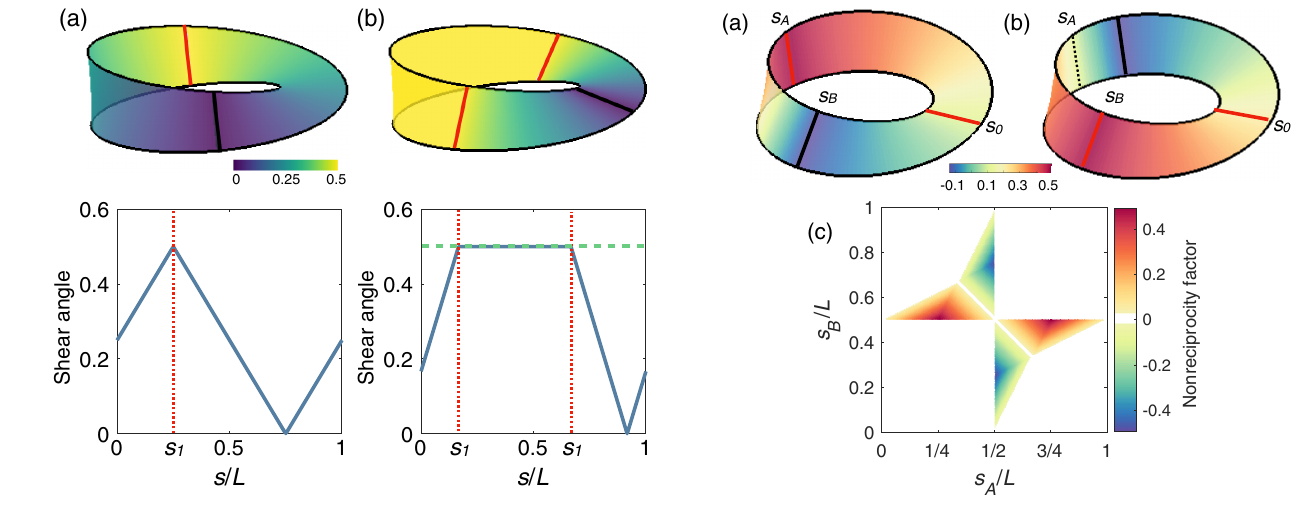
FIG. 3. Nonlinear response to shear stress. Top panels: The color indicates the magnitude of the shear angle along the Möbius strips. The red lines show the positions of the applied stresses and the dark line the position of s G . Bottom panels: Corresponding plots of θ S ð s Þ . (a) Response to a pointwise stress source σ ð s Þ ¼ σδ ð s − 1 = 4 Þ with σ ¼ K . The shear angle decays linearly from the stress source and vanishes at s ¼ 3 = 4 . (b) Nonlinearity: Response to two pointwise stress sources σ S ¼ K f δ ð s − 1 = 6 Þ − δ ½ s − ð 1 = 6 þ 1 = 2 Þ(cid:2)g . The deformations computed from the min- imization of the elastic energy as explained in Appendix A 3 vanish at s G ¼ 11 = 12 . The deformations computed from the minimization of the elastic energy (solid line) are markedly different from the linear superposition of two responses to two individual point sources (dashed